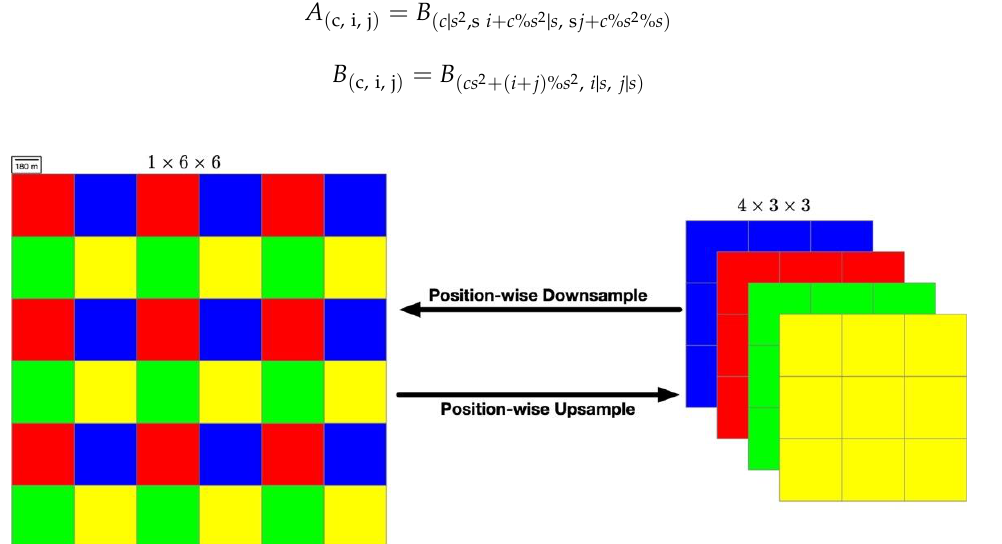
Figure 3. Diagram of the position-wise operations where the red, blue, green, and yellow cubes indicate pixels of different positions in the feature map respectively. The position-wise Downsample operation halves the size of the original feature map while the dimensions are stretched for four times. In contrast, the position-wise Upsample operation doubles the size of the feature map and reduces the dimension channel according to the position of every pixel.